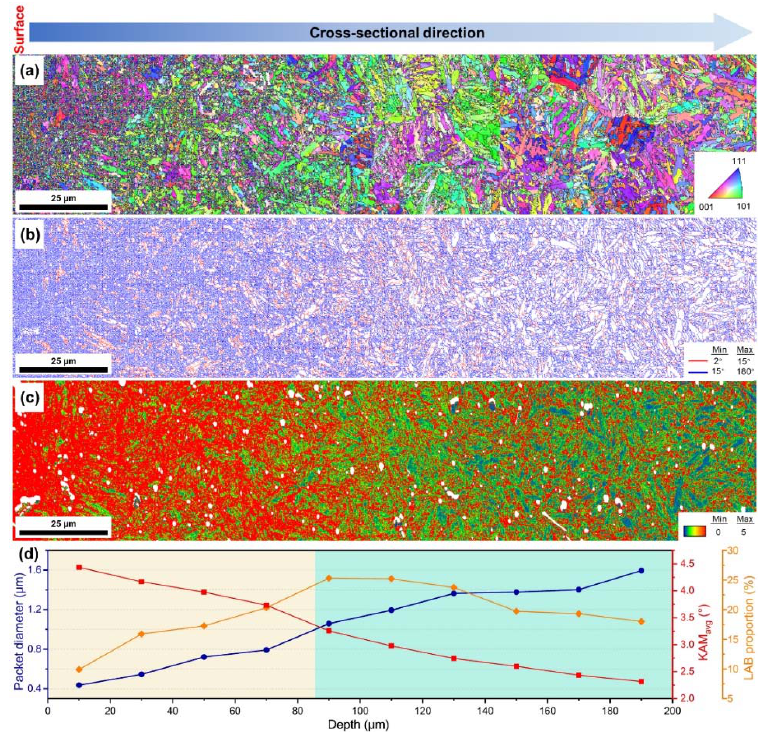
Figure 6. Cross ‐ sectional EBSD images of the M50 steel after 10 min USP treatment: ( a ) IPF map; ( b ) grain boundary map; ( c ) KAM map; ( d ) statistical results of ( a – c ).